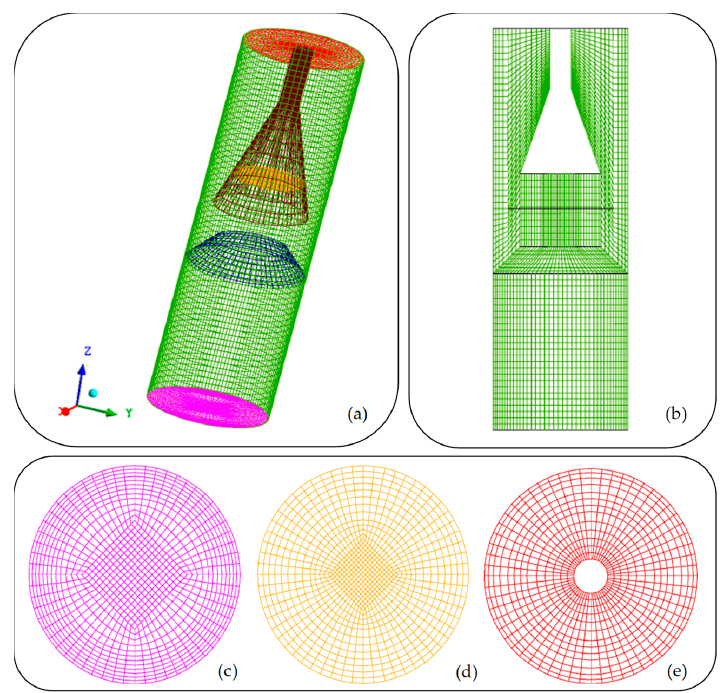
Figure 2. Mesh representation with deflector inclination upwards: ( a ) overview, ( b ) plan yz, ( c ) inlet (z = 0 m), ( d ) biogas outlet (z = 2.29 m), and ( e ) output of sludge and biogas (z = 3.58 m).